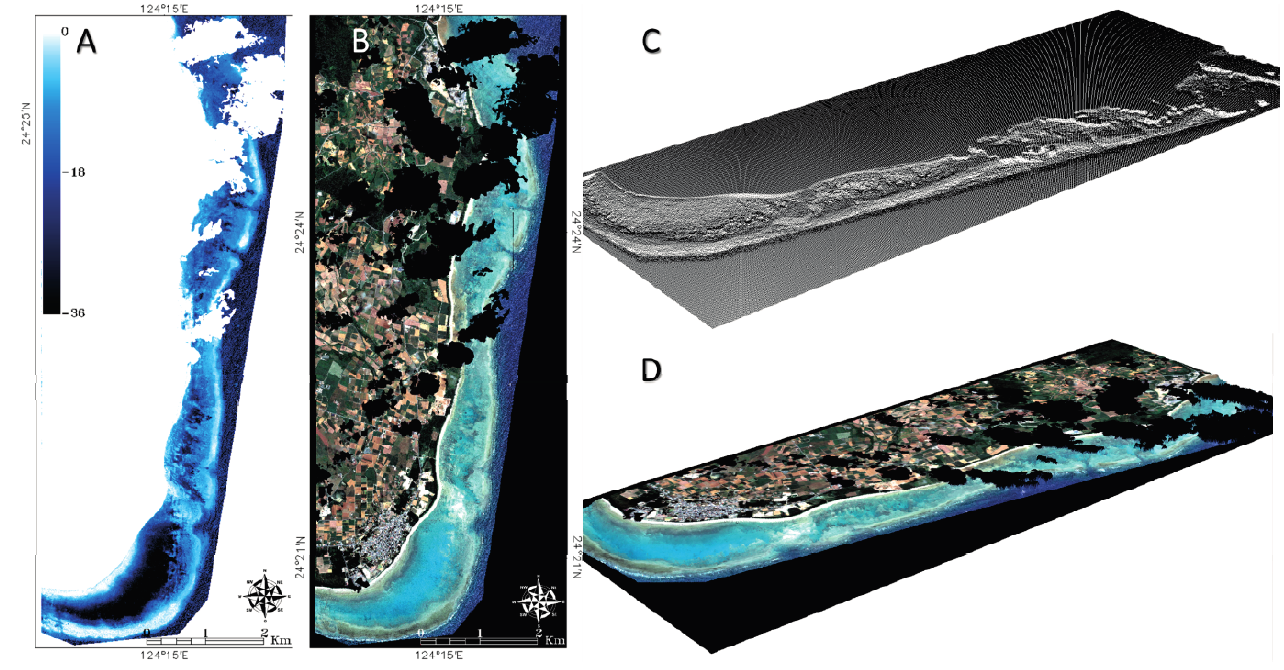
Figure 7. Maps of the ( A ) water depth and ( B ) natural-colored (RGB) data over the study site stemming from the Google Earth (GE) blue-red ratio transform and GE-derived very high resolution mosaic, respectively. Based on xyz data, ( C ) a 3D point cloud was constructed, over which the RGB image can be draped ( D